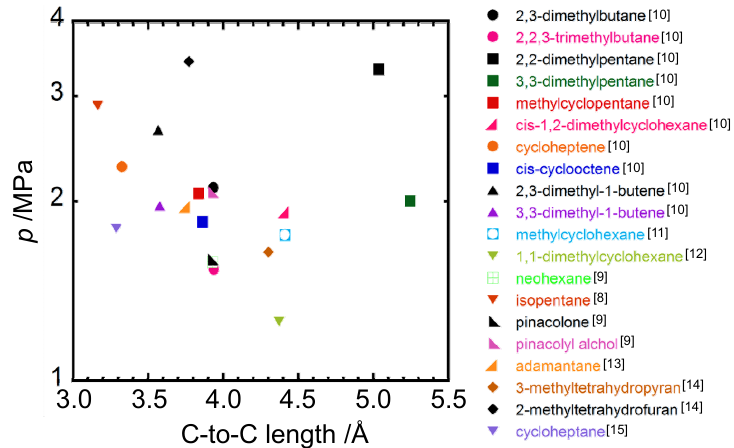
Figure 2. Correlation plot between C-to-C length of LMGS and the equilibrium pressure at 276 K.